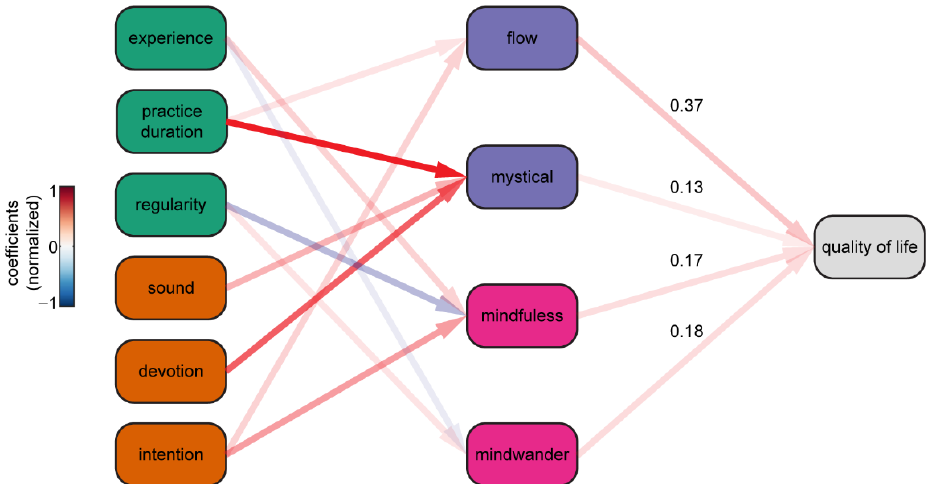
Figure 3. Path diagram showing that Engagement and Intentionality are indirectly associated with Quality of Life through their association with Altered States (Flow and Mystical Experience) and Cognitive Impact (Mindfulness and Mind Wandering).